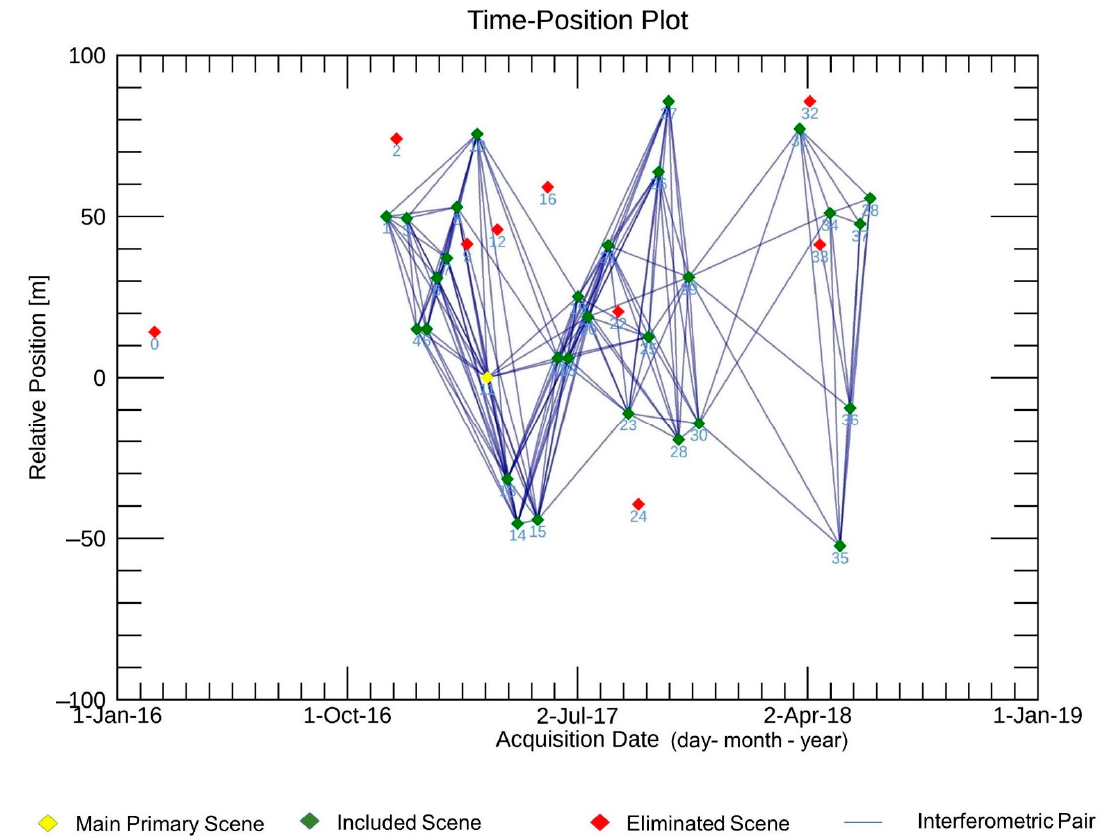
Figure 3. Spatial baseline-time plots for 39 ascending Sentinel-1 (Path 72; Frame: 73 and 77) scenes (Table 1) that were used for Small Baseline Subset (SBAS) analysis. Further shown is the distribution of the main primary scene, included and eliminated scenes, and the interferometric pairs. Scenes yielding interferograms with heavy atmospheric contributions and/or low coherence were omitted; the remaining scenes (30 scenes; acquisition period: 16 November 2016 to 15 June 2018; Table 1) were included in the SBAS analysis and were subjected to additional processing. Table 2. The distribution and rates of deformation of sites showing LOS subsidence exceeding 4 mm/y over